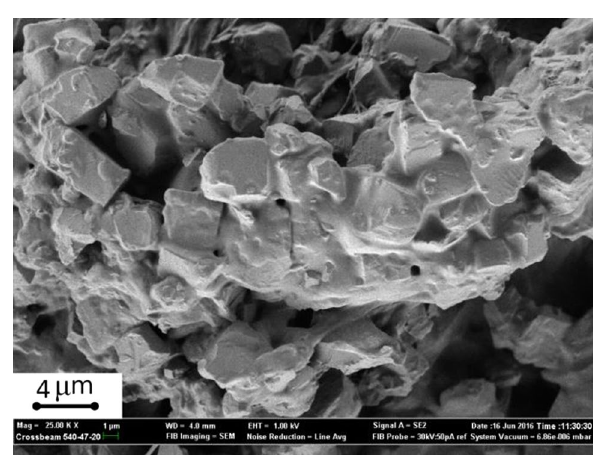
Fig. 3 SEM image of wall detail of an ZF-70